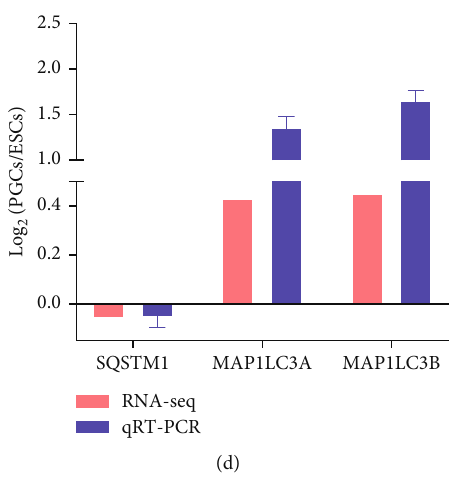
Figure 3: Enrichment analysis of DEGs in ESCs and PGCs in chicken. (a) Volcano map of DEGs between ESCs and PGCs. The red dots represent signi fi cantly upregulated genes in PGCs; the green dots represent signi fi cantly downregulated genes. Genes that are not di ff erentially expressed are shown in gray. (b) Heat map showing DEGs between ESCs and PGCs. Blue represents weakly expressed genes, and red represents highly expressed genes. (c) KEGG enrichment analysis of the DEGs. (d) Expression comparisons of autophagy genes detected by RNA-seq and qRT-PCR between ESCs and